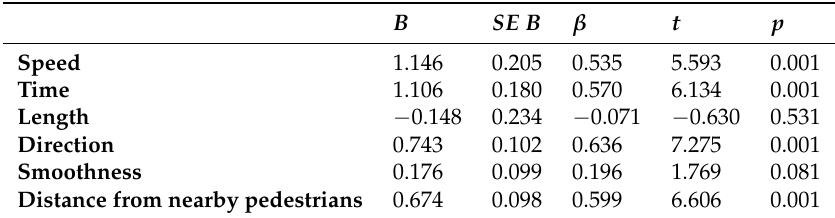
Table 1. Regression table for all examined measurements. The unstandardized coefficient ( B ), the standard error for the unstandardized coefficient ( SE B ), the standardized coefficient ( β ), the t-test statistic ( t ), and the probability value ( p